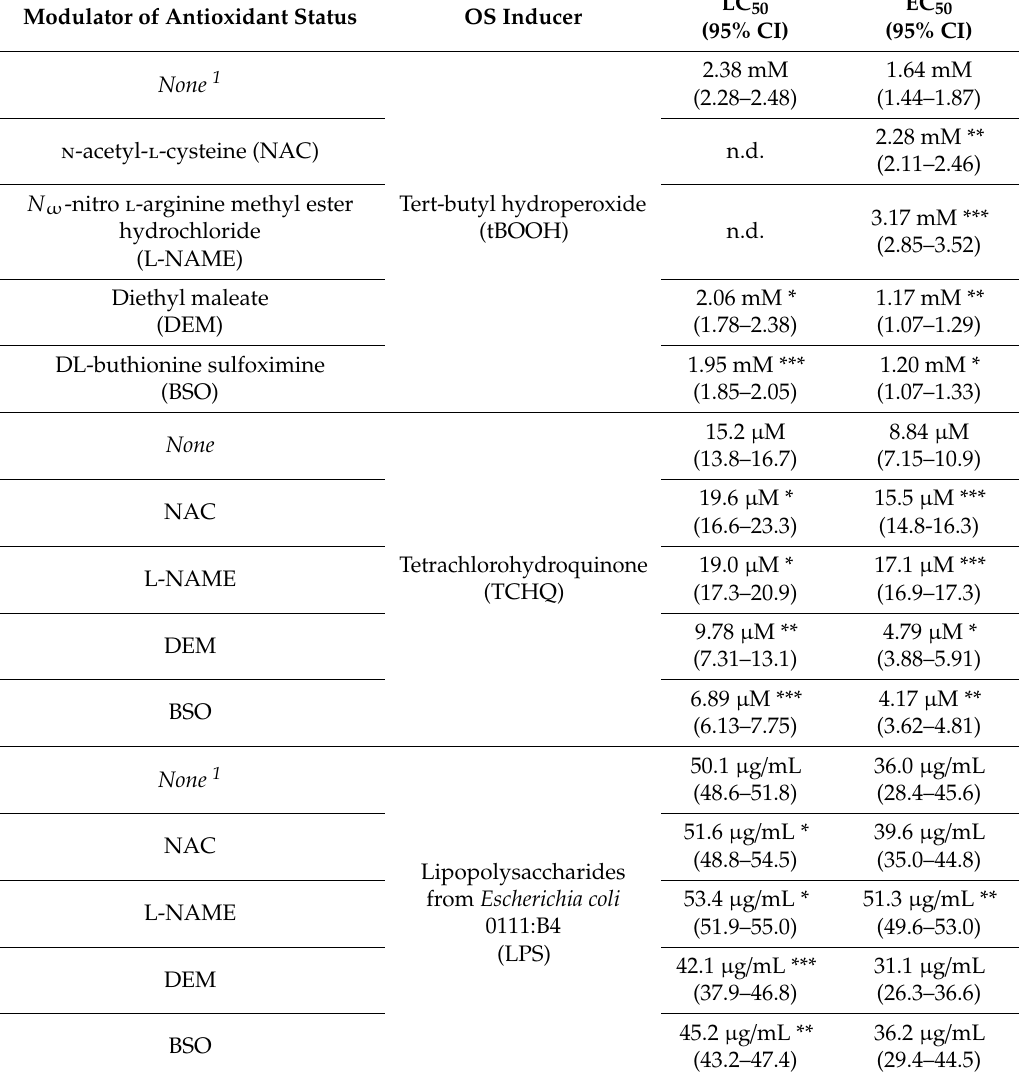
Table 2. Lethality and dysmorphogenesis e ff ective concentration values in zebrafish embryos on the modulation of developmental e ff ects produced by OS